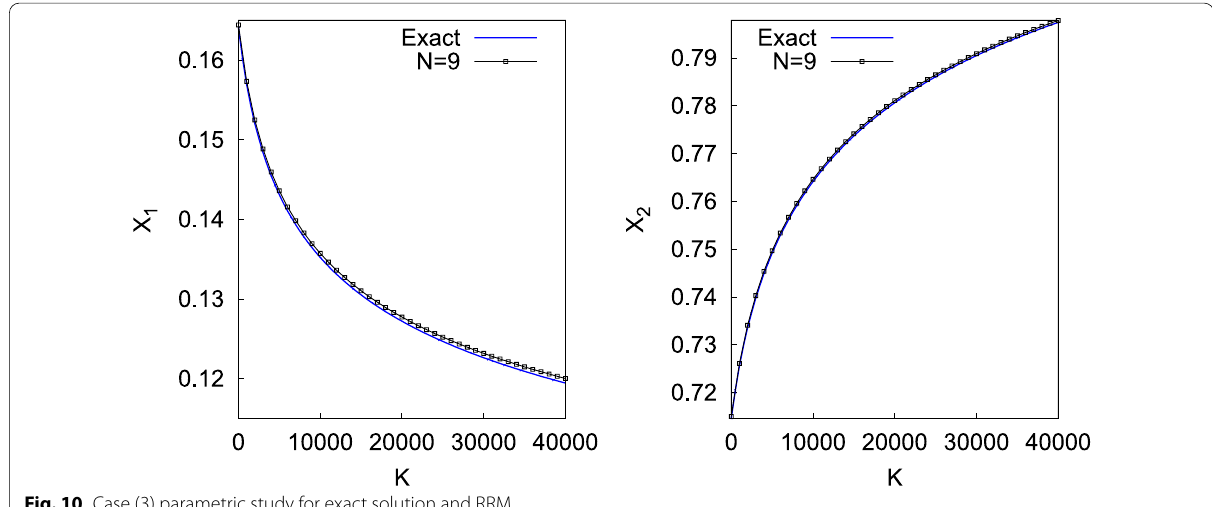
Fig. 10 Case (3) parametric study for exact solution and RRM